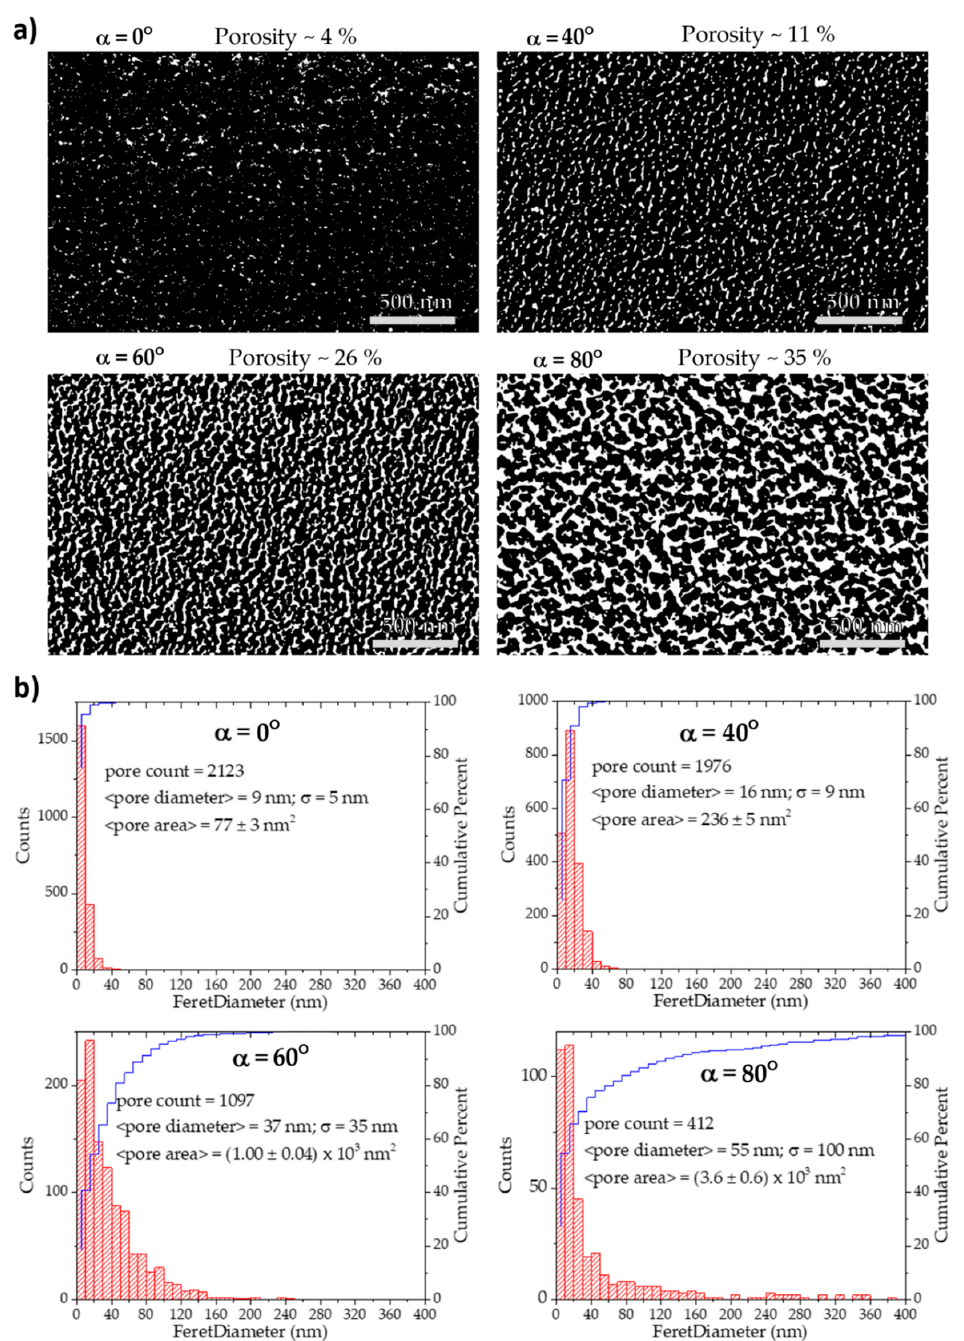
Figure 5. ( a ) Top-view SEM micrographs processed in MATLAB for surface porosity calculation and ( b ) corresponding